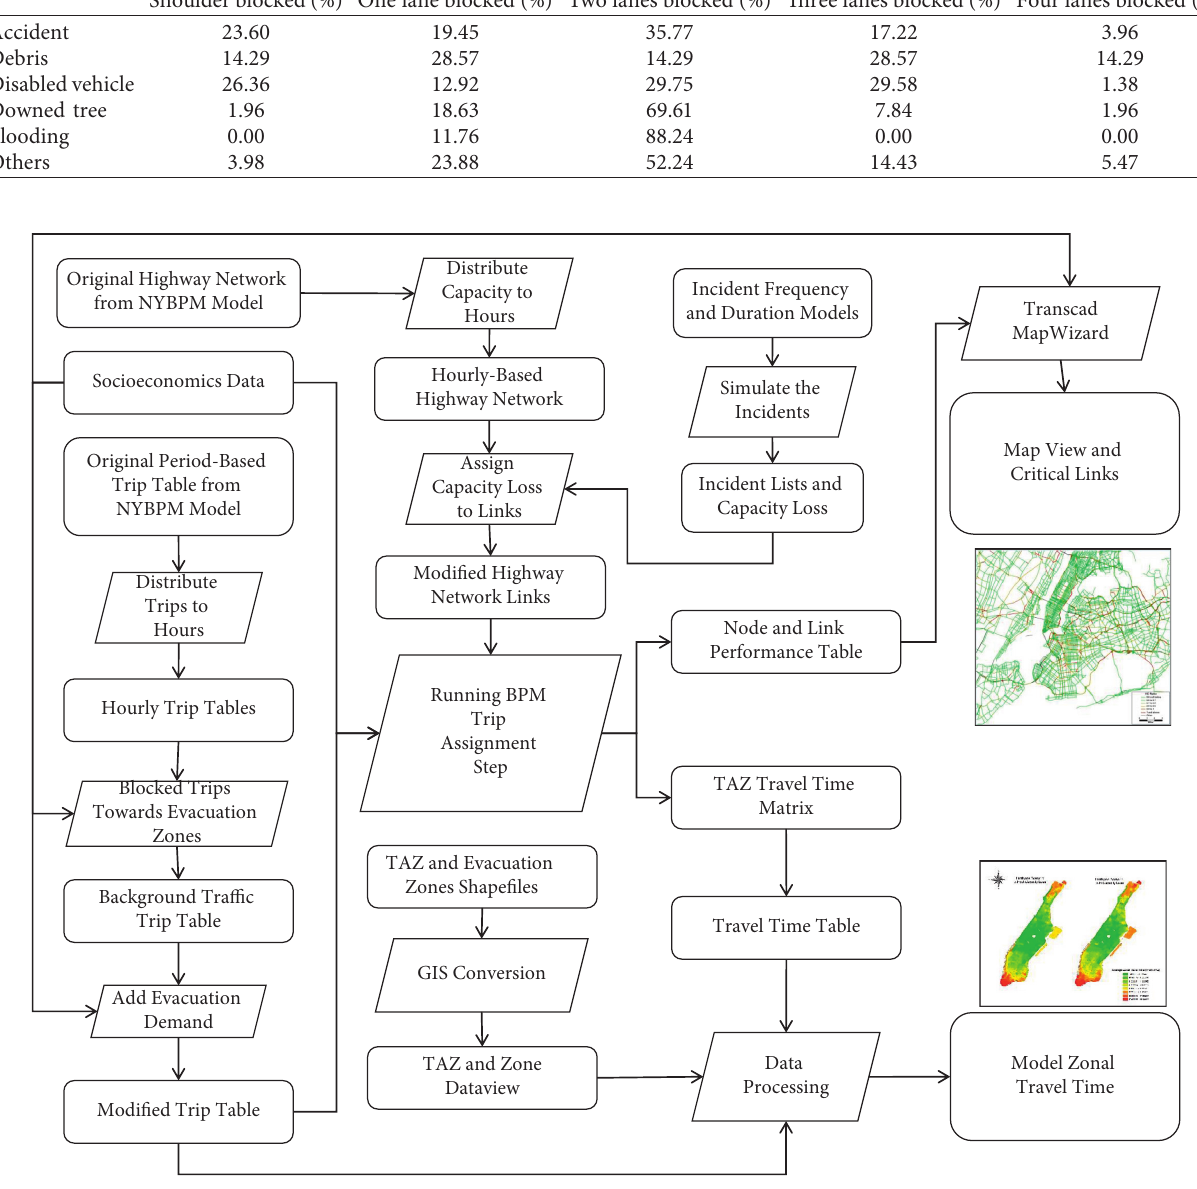
Figure 1: Procedure of network-wide demand and degradable capacity